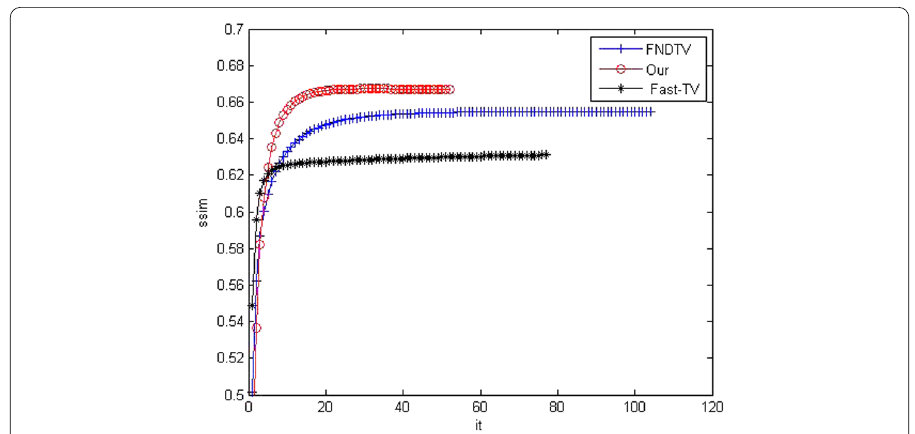
Figure 7 Changes of SSIM value versus iteration number for the three methods about motion blur with